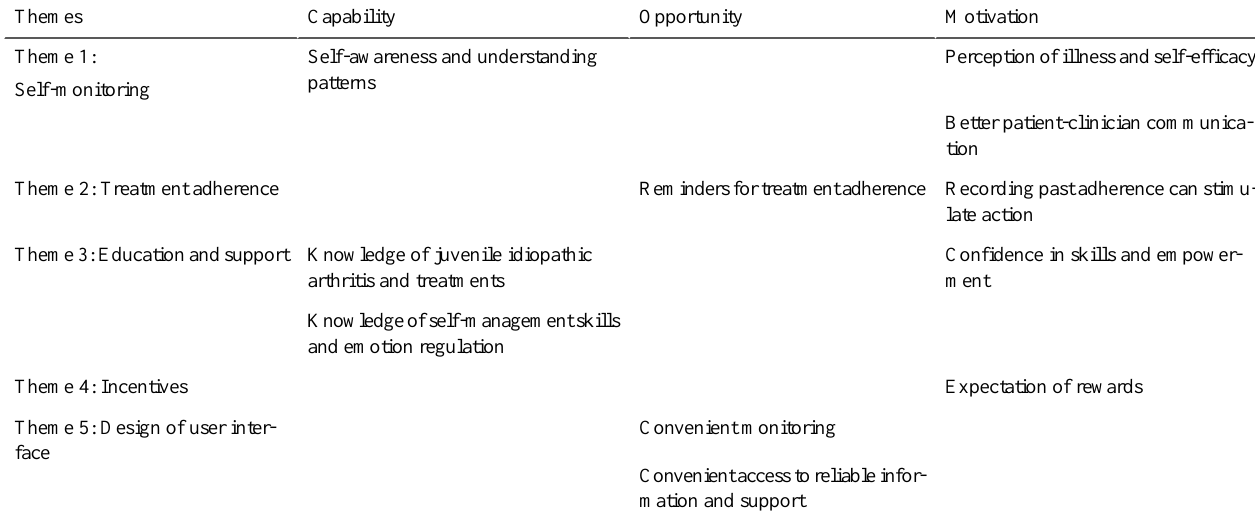
Table 2. Applying the Capability, Opportunity, Motivation-Behavior (COM-B) model to major themes identified for